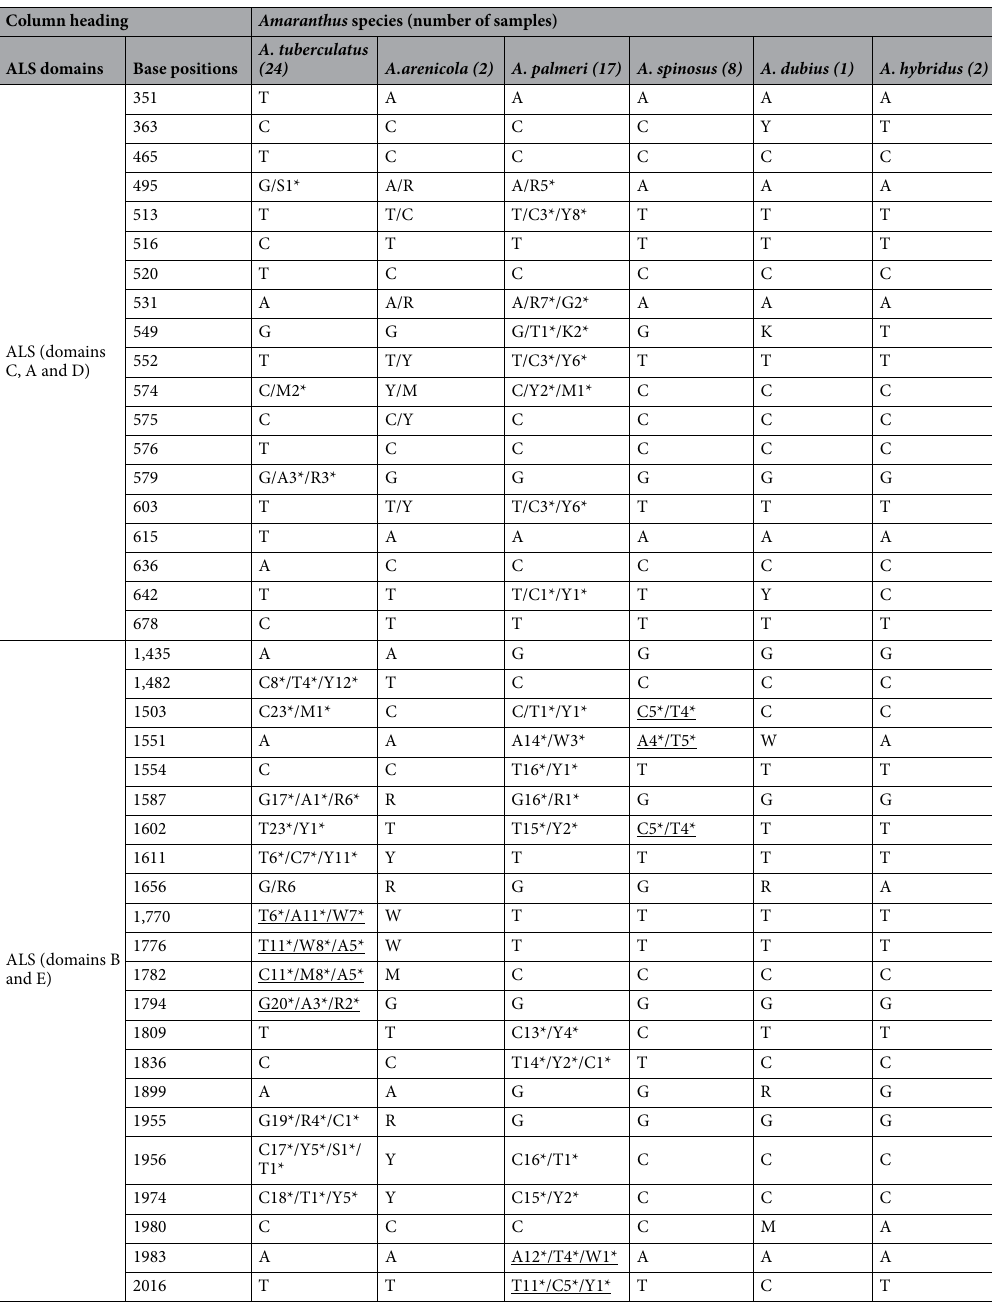
Table 1. Comparison of SNPs between the similar species: Amaranthus tuberculatus , A. arenicola , A. palmeri , A. spinosus , A. dubius and A. hybridus on ALS (domains C, A and D) and ALS (domains B and E). *The number of this kind of base on the locus. Underlines indicate mutations that separate Amaranthus tuberculatus , A. spinosus and A. palmeri into different